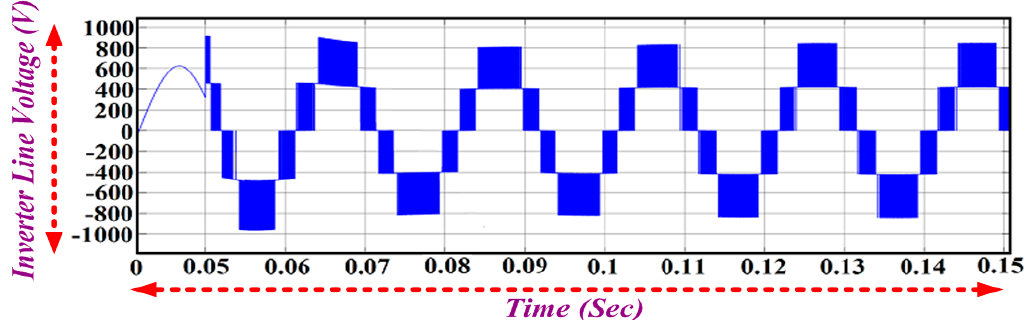
Figure 15. Inverter Line Voltage.